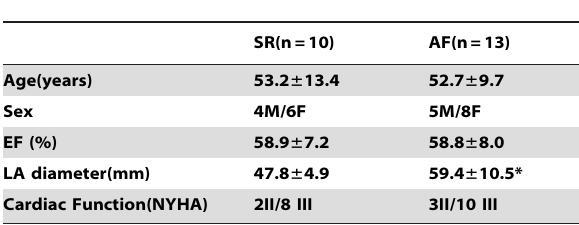
Table 1. Patients’